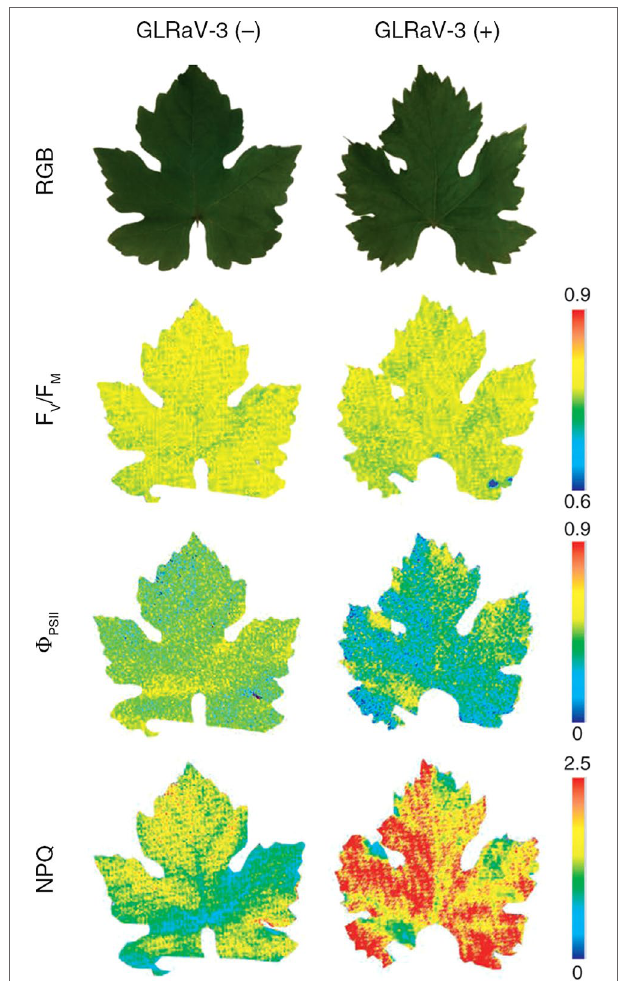
FIGURE 1 | Impact of Grapevine leafroll-associated virus 3 (GLRaV-3) infection on the photosynthesis of grapevine ( Vitis vinifera white variety ‘Malvasía de Banyalbufar’) leaves. Representative images of PSII efficiency (F V / F M , Φ PSII ) and non-photochemical quenching (NPQ) are shown. GLRaV-3 (−): control leaves; GLRaV-3(+): infected leaves; RGB: color reflectance pictures. Reproduced with permissions from Montero et al.